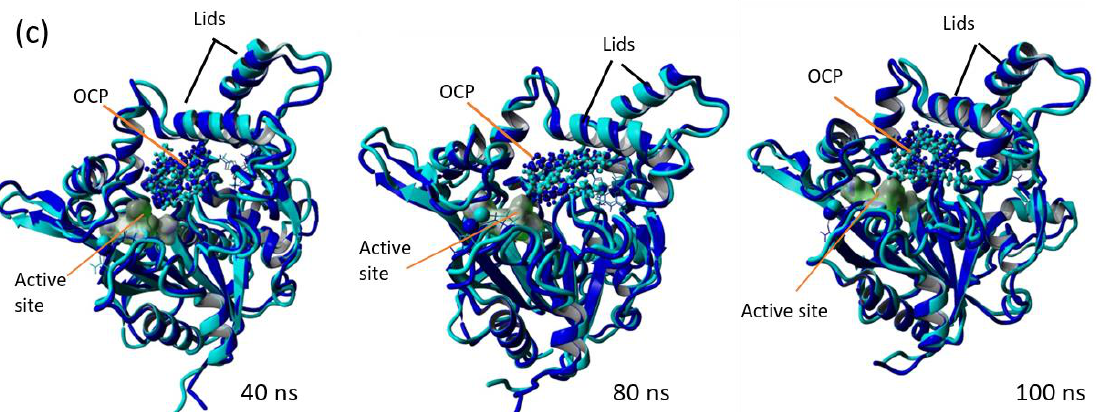
Figure 8. Superposition of wt_T1 closed structure (grey), wt-T1_OCP (blue) and 3M_OCP (cyan). ( a ) Superimposition of the closed structure of T1 lipase with wt-T1_OCP extracted from MD simu- lation trajectories at 100 ns. ( b ) Superimposition of the closed structure of T1 lipase with 3M_OCP extracted from MD simulation trajectories at 100 ns. ( c ) Superimposition of complexed wt-T1_OCP and 3M_OCP at 40, 80 and 100 ns.